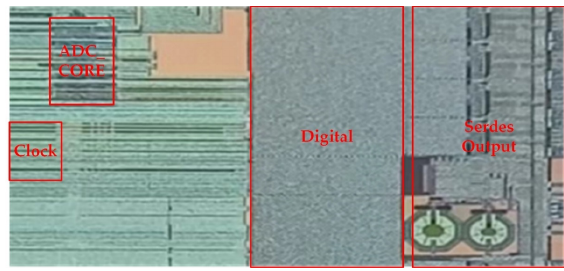
Figure 14. ADC_CORE layout, including input buffer, SHA, and Stage1 – 6. Figure 15. 12-Bit 1 GS/s Pipelined ADC Figure 15. 12-Bit 1 GS/s Pipelined ADC micrograph.